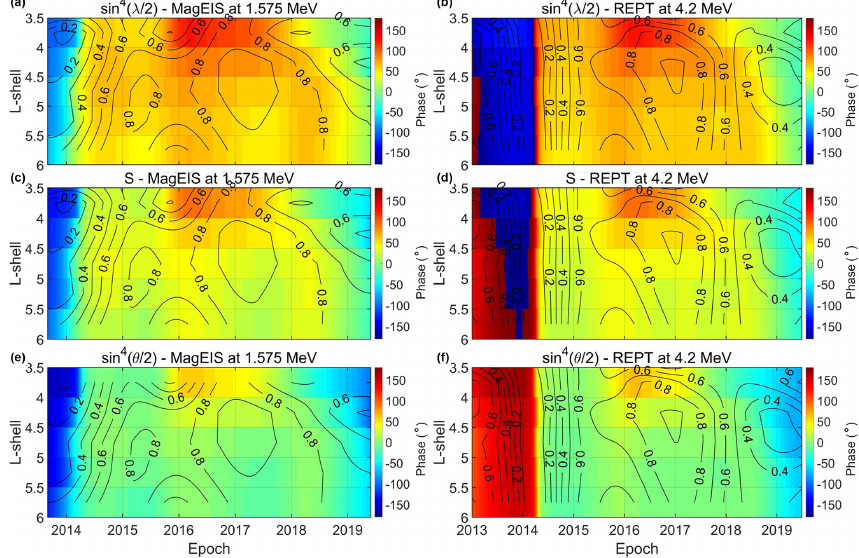
Figure 9. Same as Fig. 8 for the 1.575MeV electron flux from MagEIS (a, c, e) and 4.2MeV electron flux from REPT (b, d, f)